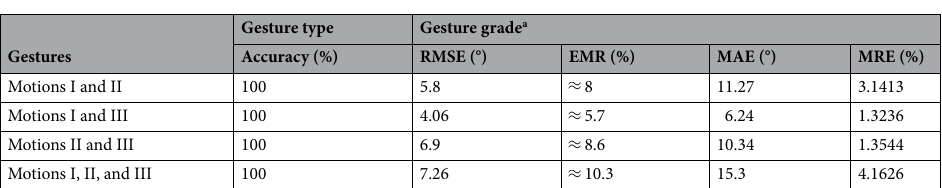
Table 2. Accuracy of estimated gesture type and grade error in different motions (wrist extension/flexion (I), clenching (II), and thumb extension/flexion (III)). RMSE, root mean square error; EMR, error in movement range; MAE, maximum absolute error; MRE, mean relative error. a Gesture grade is the stage of the motion completeness in a range between 90 to 180